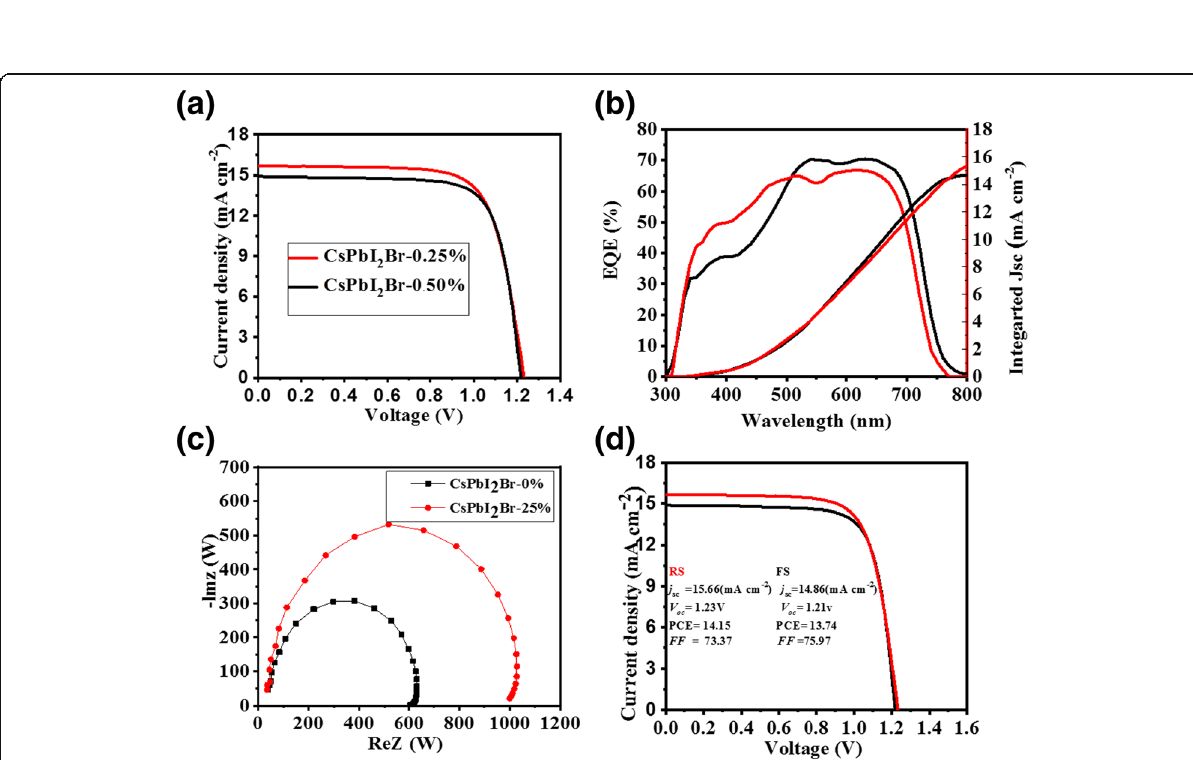
Fig. 3 Lightweight J – V curves of the solar cells based on the CsPbI 2 Br-ZnCl 2 -MnCl 2 films ( a ). EQE spectra and integrated J sc of the solar cells based on the CsPbI 2 Br-0.25% (red) and the CsPbI 2 Br-0% (black) films ( b ). Nyquist plots ( c ). J – V characteristics under the directions of reverse and forward scanning ( d